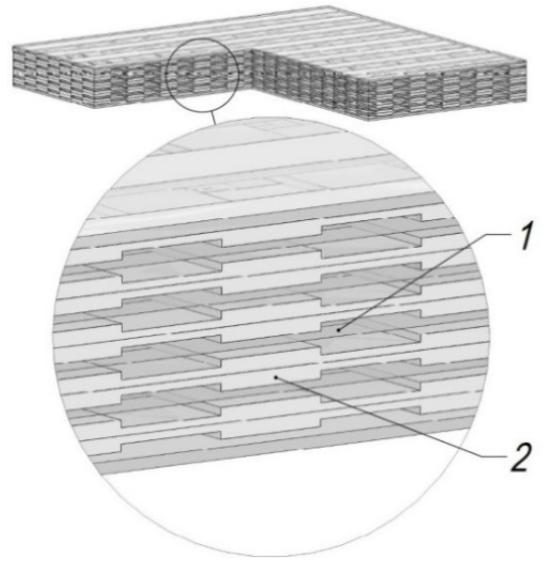
Figure 1. Composite material: 1—binding agent; 2—reinforcement (carbon or glass